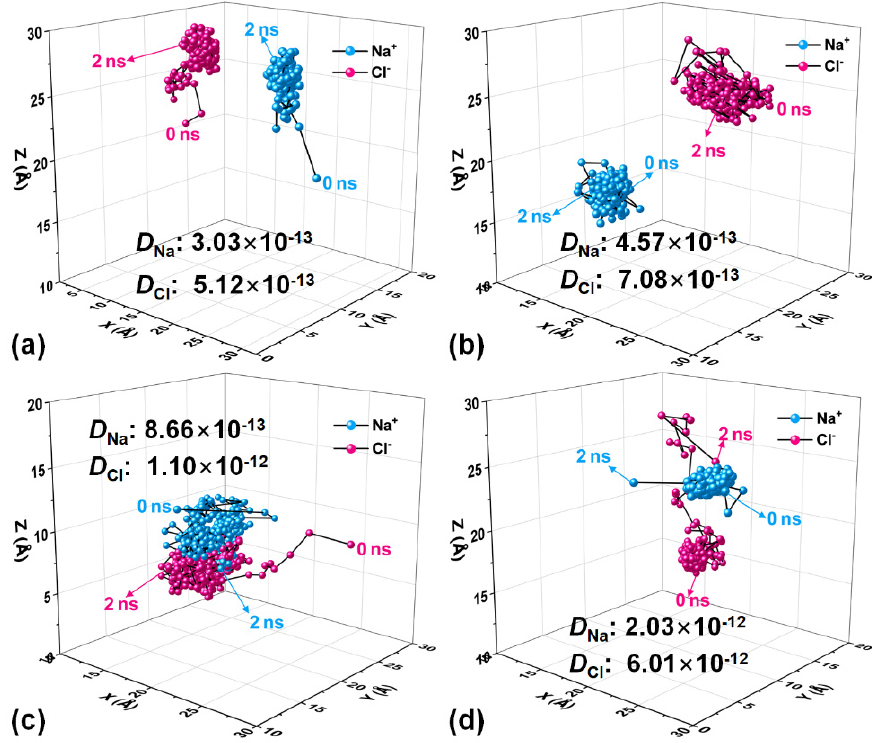
Figure 8. Time-dependent spatial diffusion trajectories of Na + and Cl − ions inside the PPy coating at 298 ( a ), 328 ( b ), 358 ( c ) and 388 K ( d ) along with the detailed diffusion coefficients for Na + and Cl − ions labeled in each figure (unit: m 2 /s).